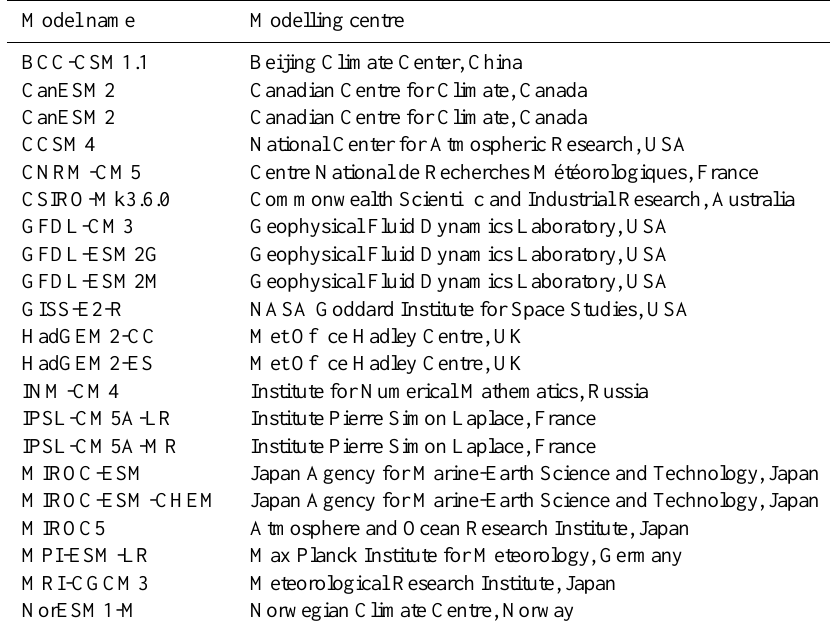
Table 1. CMIP5 models examined in this study. Model